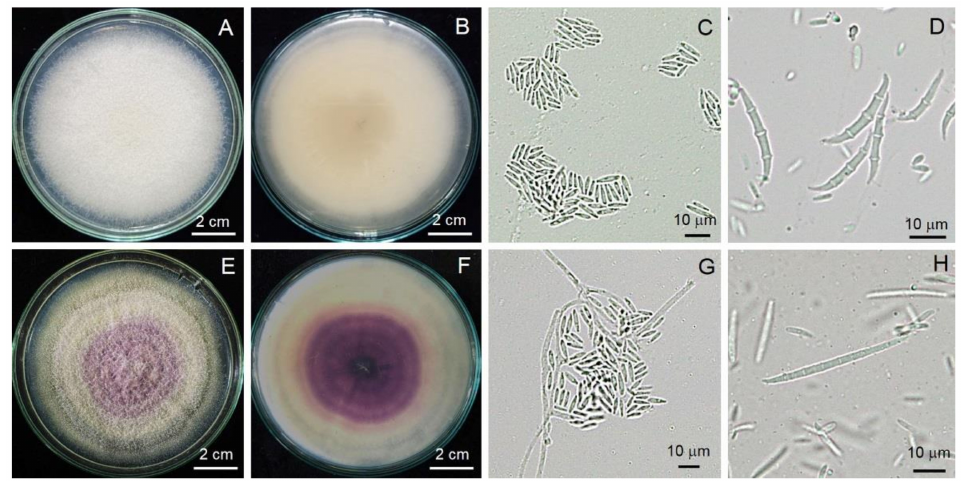
Figure 4. General morphology of Fusarium sp. FUO01 ( A – D ) and FUP01 ( E – H ): Colony on PDA from the top ( A , E ) and bottom view ( B , F ); hyphae and diverse shape of conidia ( C , D , G , H